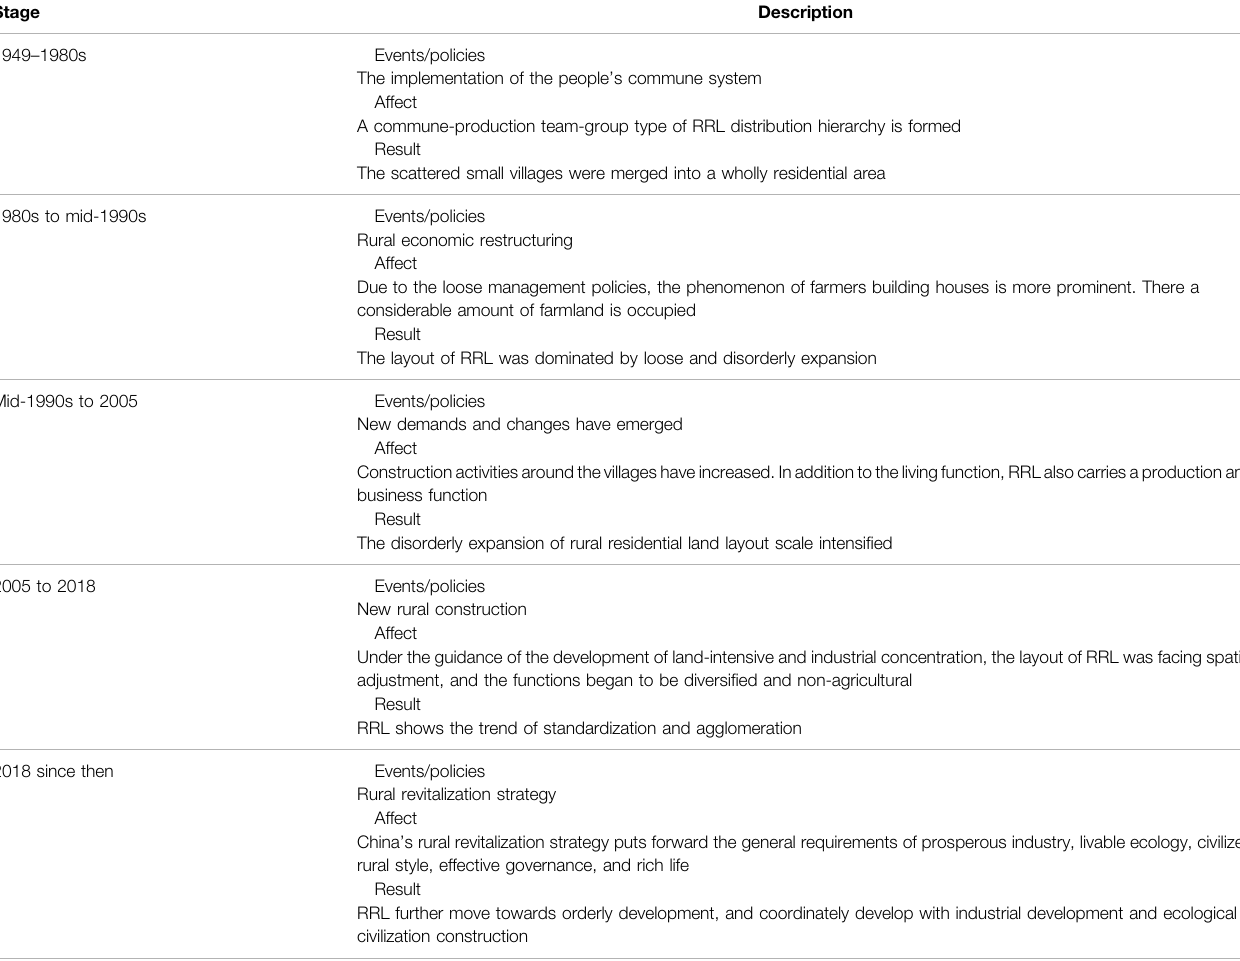
TABLE 5 | The 5 stages of China ’ s policy system impact on